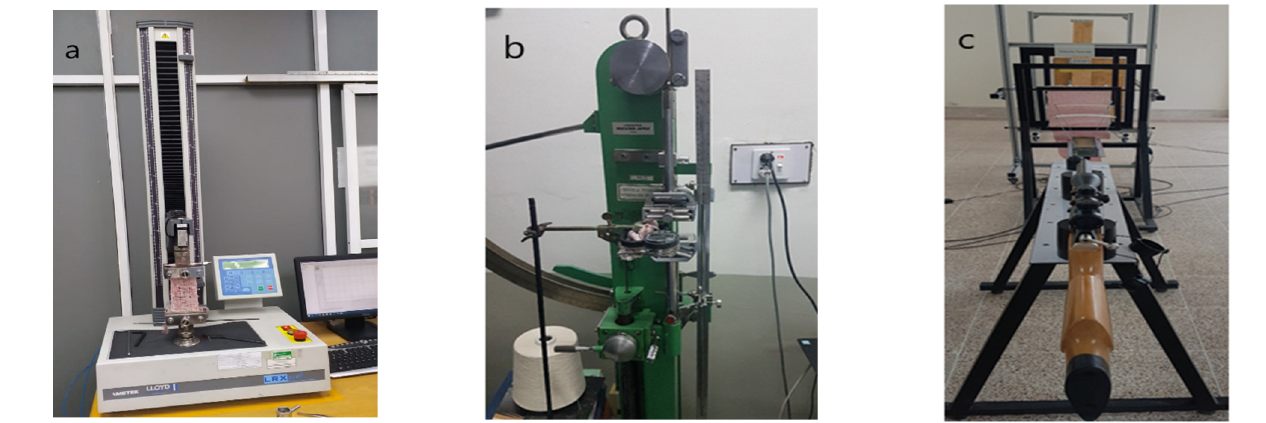
Figure 2. ( a ) Semi-automatic dobby weaving Loom used for making fabric samples in this study. ( b ) Fabric sample during production stage. Closer view of the fabric is shown on the right clearly showing warp and weft yarns.